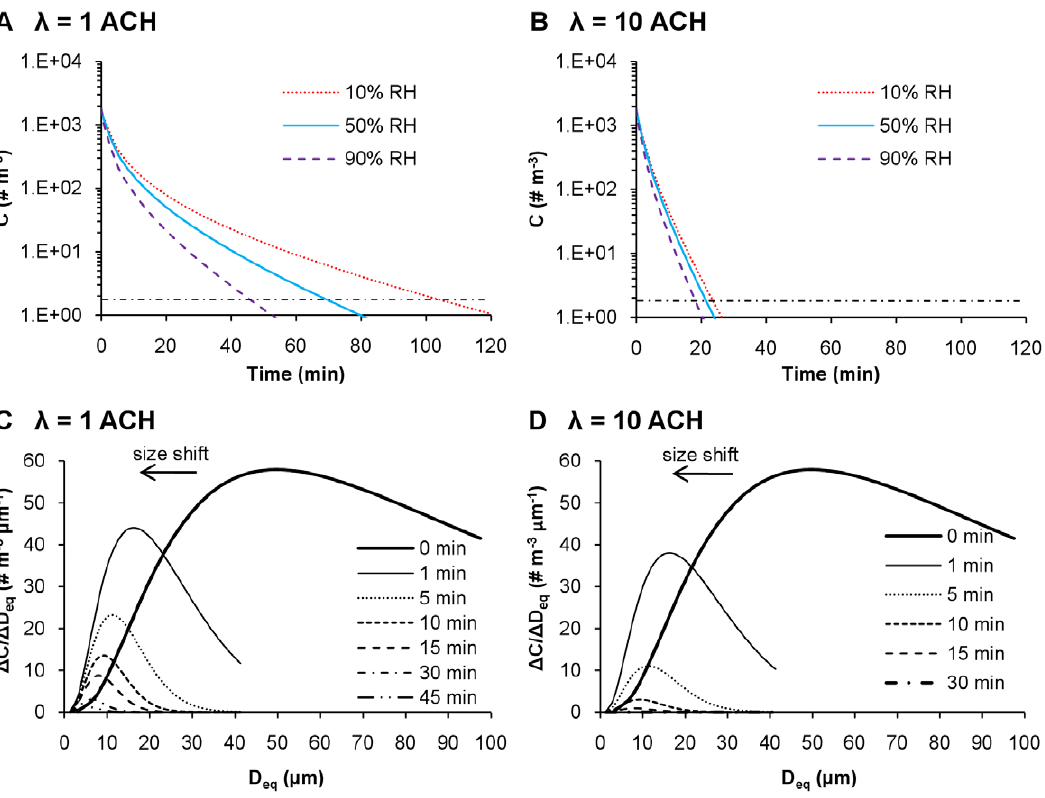
Figure 3. Evolution of infectious airborne IAV concentrations and size distributions. Time series of airborne, infectious IAV concentrations following a cough into residential (A) and public (B) settings at 10–90% RH. The horizontal dashed line indicates 99.9% removal. Evolution over time of airborne, infectious IAV size distribution following a cough into residential (C) and public (D) settings at 50% RH.